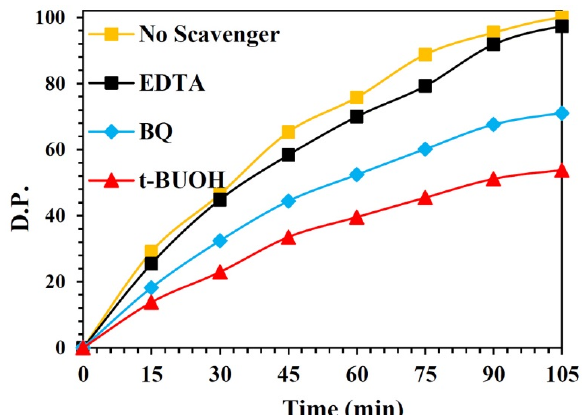
-WO sample for degradation of Nitenpyram insecticide under visible light irradiation in 2 3 presence of different